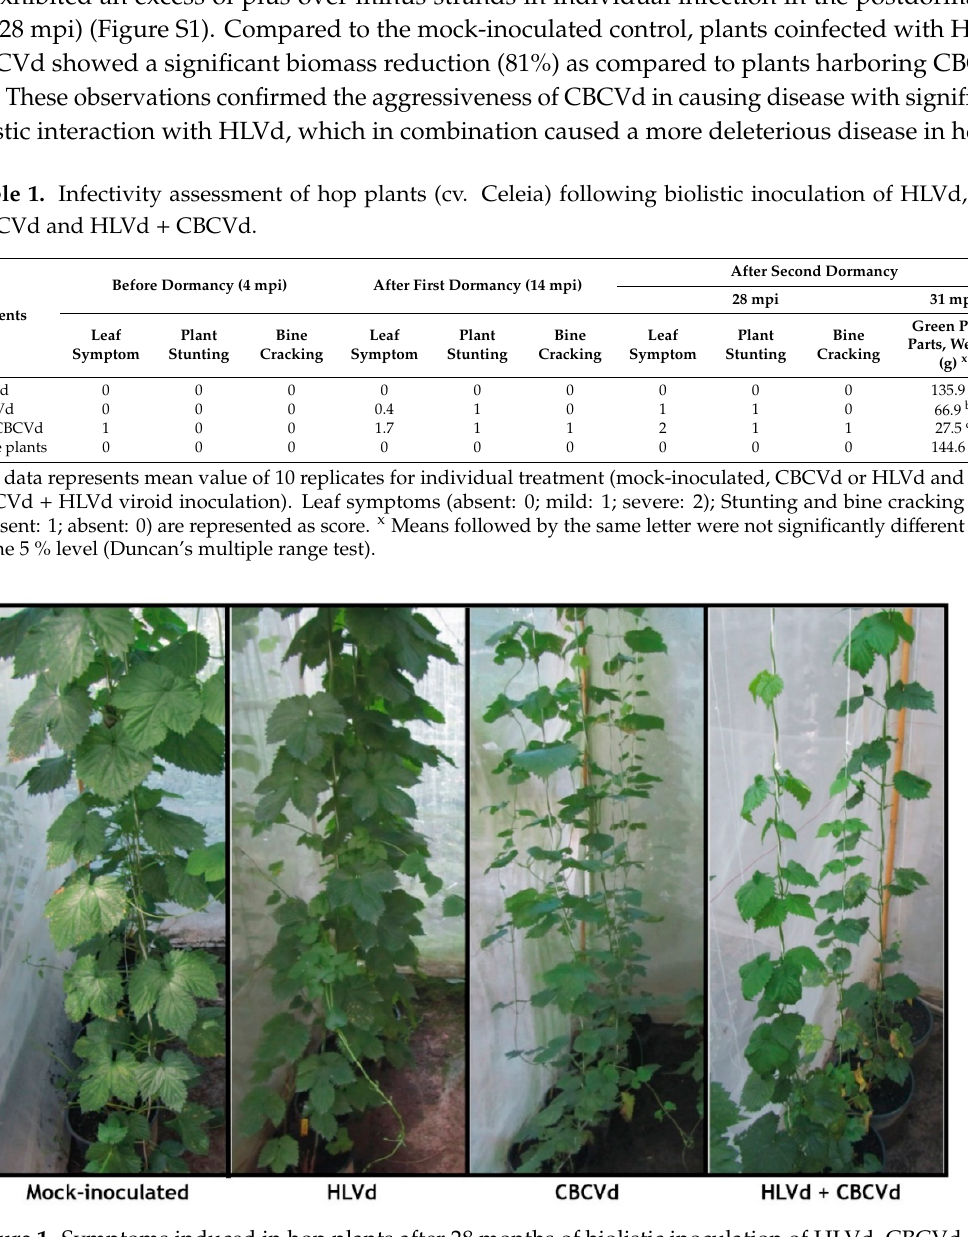
Figure 1. Symptoms induced in hop plants after 28 months of biolistic inoculation of HLVd, CBCVd, and HLVd-CBCVd inoculum. The CBCVd infected and HLVd-CBCVd coinfected plant showing stunted growth, smaller leaves with chlorosis compared to control. Table 1. Infectivity assessment of hop plants (cv. Celeia) following biolistic inoculation of HLVd, CBCVd and HLVd + CBCVd.